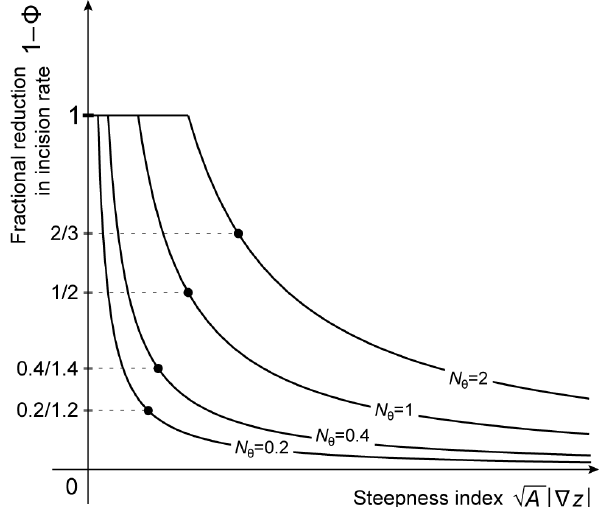
Figure 6. Comparison of the relative influence of incision thresh- olds with different magnitudes. We present curves of the quantity √ A |∇ z | for four different values of 1 − (cid:56) vs. the steepness index √ N θ . The black dots show the values of A |∇ z | and 1 − (cid:56) that corre- spond to hillslope–valley transitions. The curve with N θ = 0 . 2, the smallest of the four values of N θ , starts with a short horizontal seg- ment and then descends steeply and approaches 0 rapidly. Further- more, its black dot corresponds to the value 1 − (cid:56) = 0 . 2 / 1 . 2 = 1 / 6. By contrast, the curve with the largest value, N θ = 2, starts with a long horizontal segment, descends gradually, approaches 0 slowly, and has a black dot with 1 − (cid:56) = 1 / 3 = 0 . 333. These differences show that as N θ increases, (a) incision is fully suppressed by the threshold in bigger portions of hillslopes, (b) the steepness index must reach greater values for the influence of the threshold to start becoming negligible, and (c) the hillslope–valley transition occurs at larger values of 1 − (cid:56) ; i.e., the threshold has a strong influence not only on hillslopes, but also on the valley